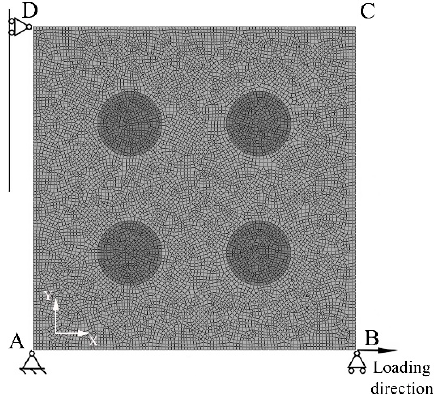
Figure 2. Schematic of the periodical boundary condition.